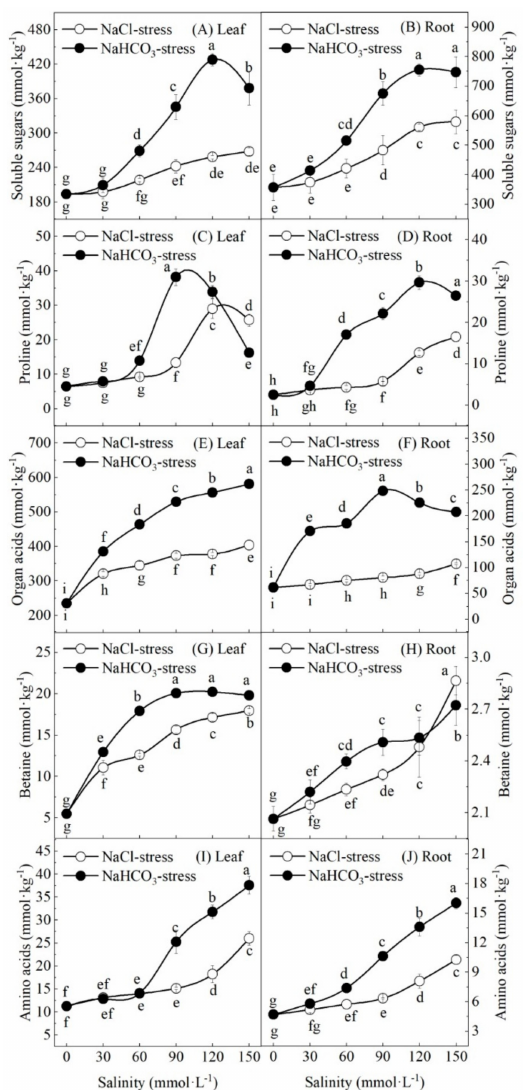
Figure 6. E ff ects of NaCl and NaHCO 3 stresses on soluble sugar ( A , B ), proline ( C , D ), organic acid ( E , F ), betaine ( G , H ), and amino acid ( I , J ) content in the leaves and roots of common bean ( Phaseolus vulgaris ). Common beans were treated with NaCl (30–150 mmol · L − 1 , pH 6.65–6.86) and NaHCO 3 (30–150 mmol · L − 1 , pH 8.17–8.27) stresses. Data points and bars represent the mean ± SD of